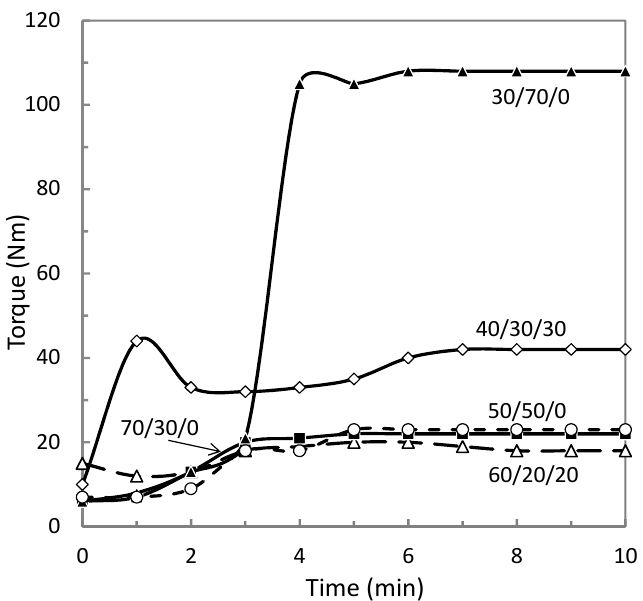
Figure 2. Torque of the screw extruder as a function of time for different ETFE/AP/MK composi- tions in wt %. AP was synthesized at 270 °C. ETFE, ethylene tetrafluoroethylene; AP, aluminum polyphosphate; MK, metakaolin.